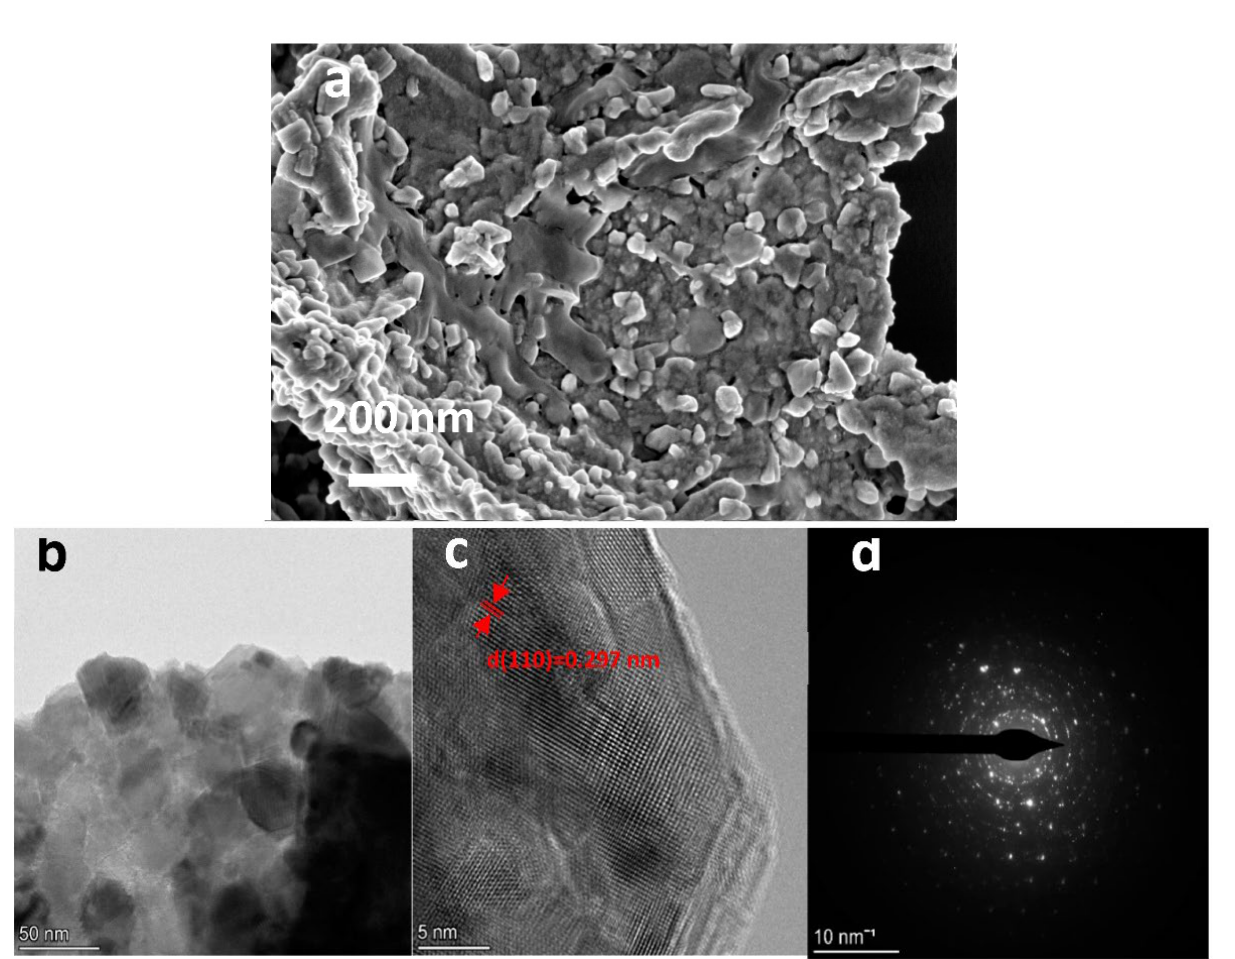
Figure 2. ( a ) SEM image of (SmSr) 0.95 Co 0.9 Pt 0.1 O 3 . ( b , c ) HRTEM images for (SmSr) 0.95 Co 0.9 Pt 0.1 O 3 . ( d ) Corresponding higher resolution SAED patterns.